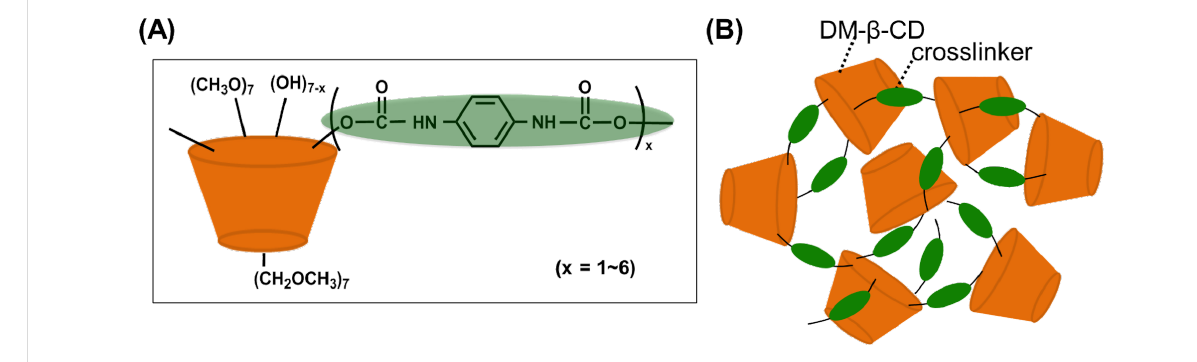
Figure 1: (A) Chemical structure and (B) schematic illustration of DM- β -CD/PDI polymer.